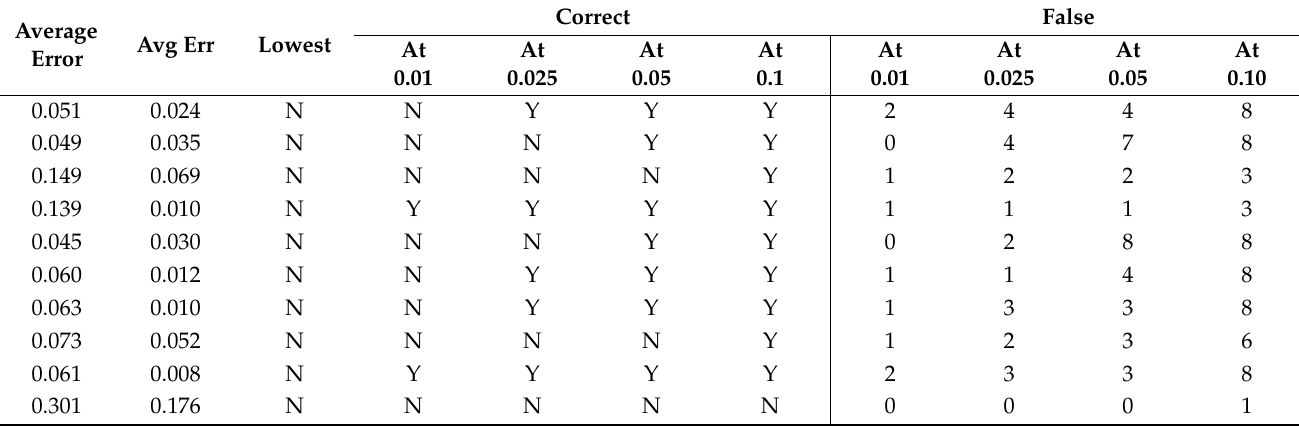
Table A76. Set 1, trials 41–50 summary data (actual PR